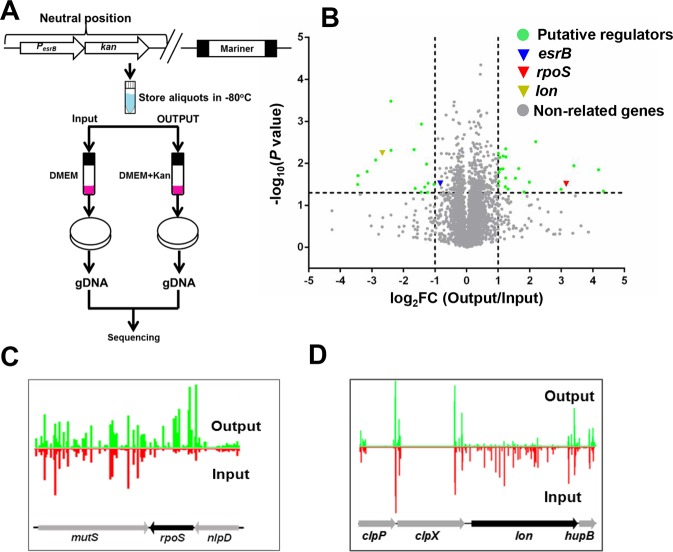
Identification of factors regulating the expression of the response regulator EsrB with a transposon insertion sequencing (Tn-seq) screen.(A) Schematic of Tn-seq strategy used for finding putative esrB regulators. A transposon library was created in a strain harboring a PesrB-Kan fusion (inserted in a neutral position on the chromosome), which yields Kan resistance when the esrB promoter is active. The library was grown in DMEM conditions, which induces the esrB promoter, in either the absence or presence of Kan. The sites and abundance of transposon insertions under the two conditions were compared. (B) Volcano plot showing the output/input fold change (FC) in reads of genes as revealed by Tn-seq analysis. The genes of interest were highlighted with cut-off of log2 FC > 1 or FC < -1, and P value < 0.05 (a measure of the concordance of hits throughout the TA sites in a gene). (C-D) Artemis plots of the abundance of reads in rpoS (D) and lon (E) in DMEM (red) versus DMEM-Kan (green) medium. The height of the red and green bars correlates with the number of reads.